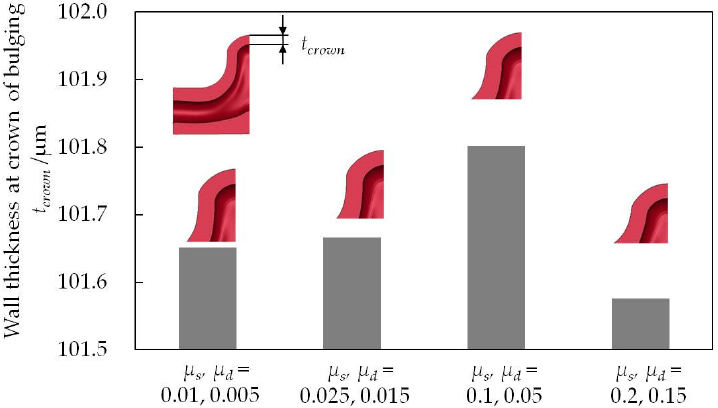
Figure 15. E ff ect of friction coe ffi cient on wall thickness at bulged crown of a micro-T-shape tube ( p h = Figure 15. Effect of friction coefficient on wall thickness at bulged crown of a micro ‐ T ‐ shape tube ( p h 50 MPa, ∆ L 1 = 150 µ = 50 MPa, Δ L 1 = 150 μ m). Figure 15. Effect of friction coefficient on wall thickness at bulged crown of a micro ‐ T ‐ shape tube ( p h = 50 MPa, Δ L 1 = 150 μ m). Figure 15. Effect of friction coefficient on wall thickness at bulged crown of a micro ‐ T ‐ shape tube ( p h = 50 MPa, Δ L 1 = 150 μ m).